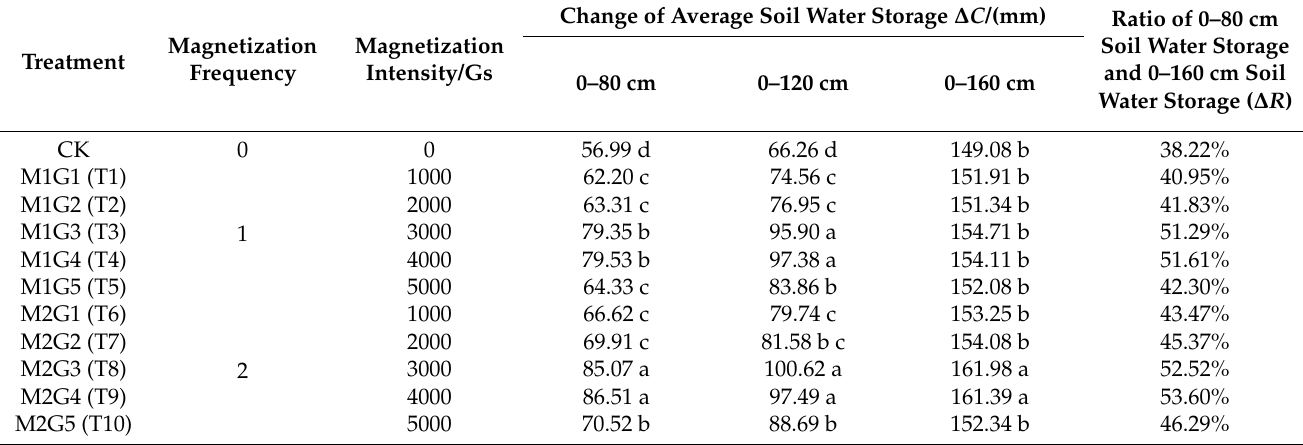
Table 4. Cumulative change in average soil water storage capacity in different soil layers under magnetized water irrigation treatment.